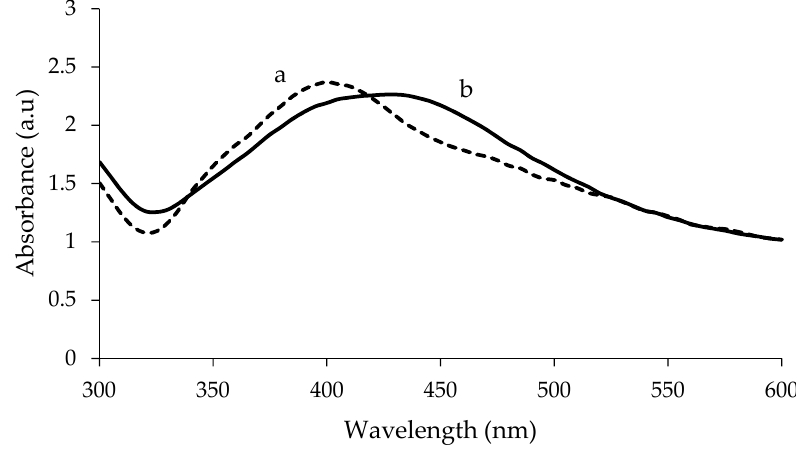
Figure 1. Comparison of UV-Visible spectrum between polyethylene glycol (PEG)-coated ( a ) and uncoated ( b ) chemically synthesised Silver nanoparticles (AgNPs).